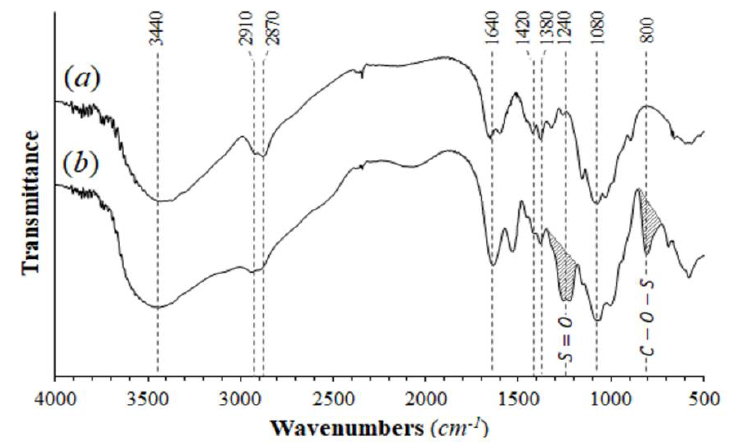
Figure 3. FTIR spectra: ( a ) chitosan and ( b ) chitosan sulfate.